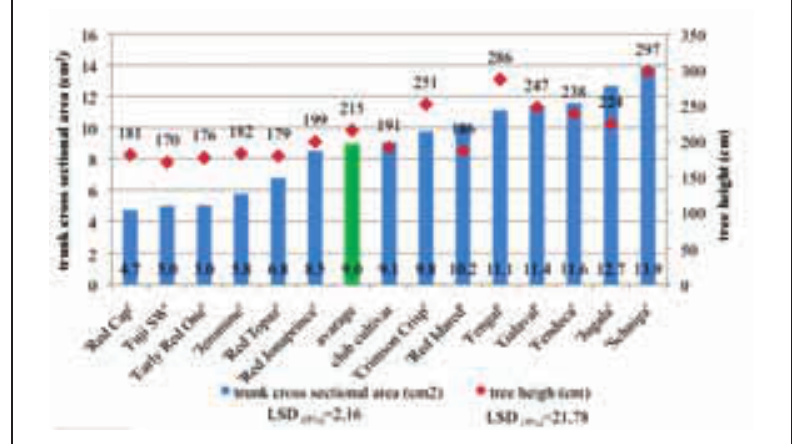
Figure 1: Trunk cross sectional area (TCSA) and tree height of apple cultivars (cm 2 , cm) (Nyírbátor, 2013)